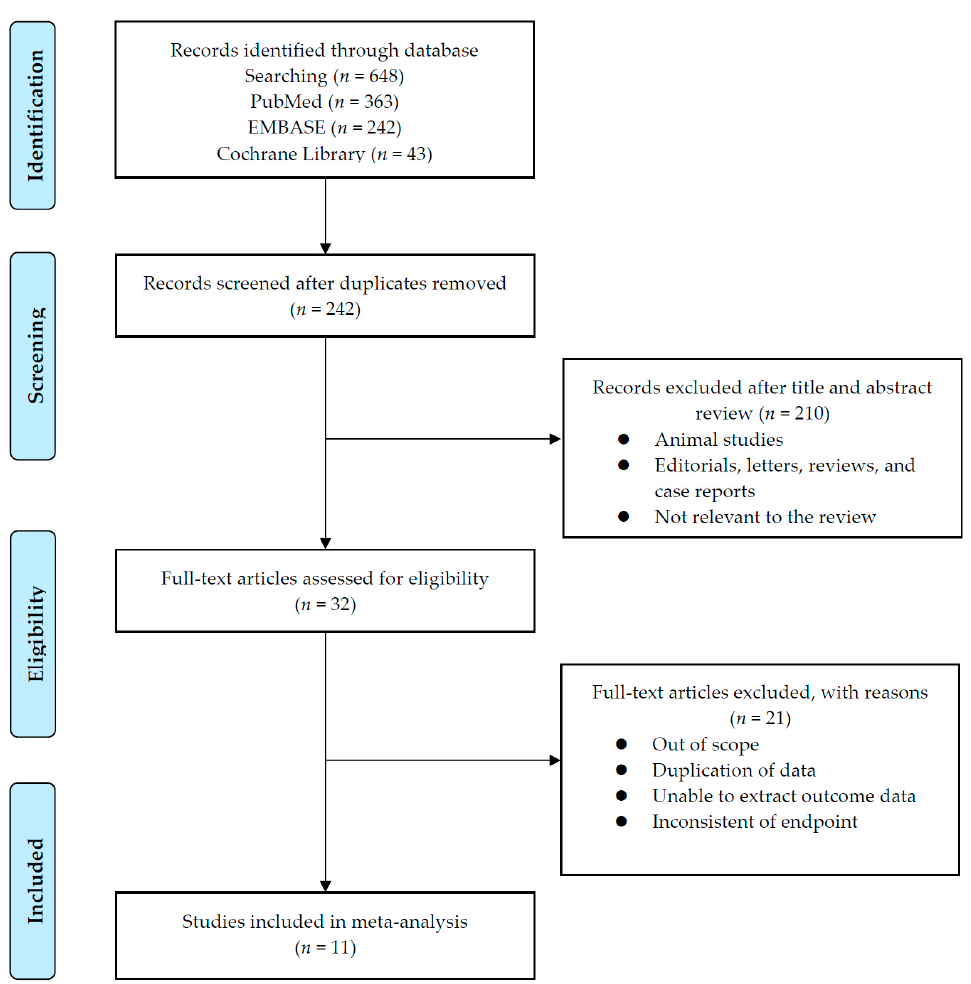
Figure 1. Flowchart of Preferred Reporting Items for Systematic Reviews and Meta-analysis (PRISMA).